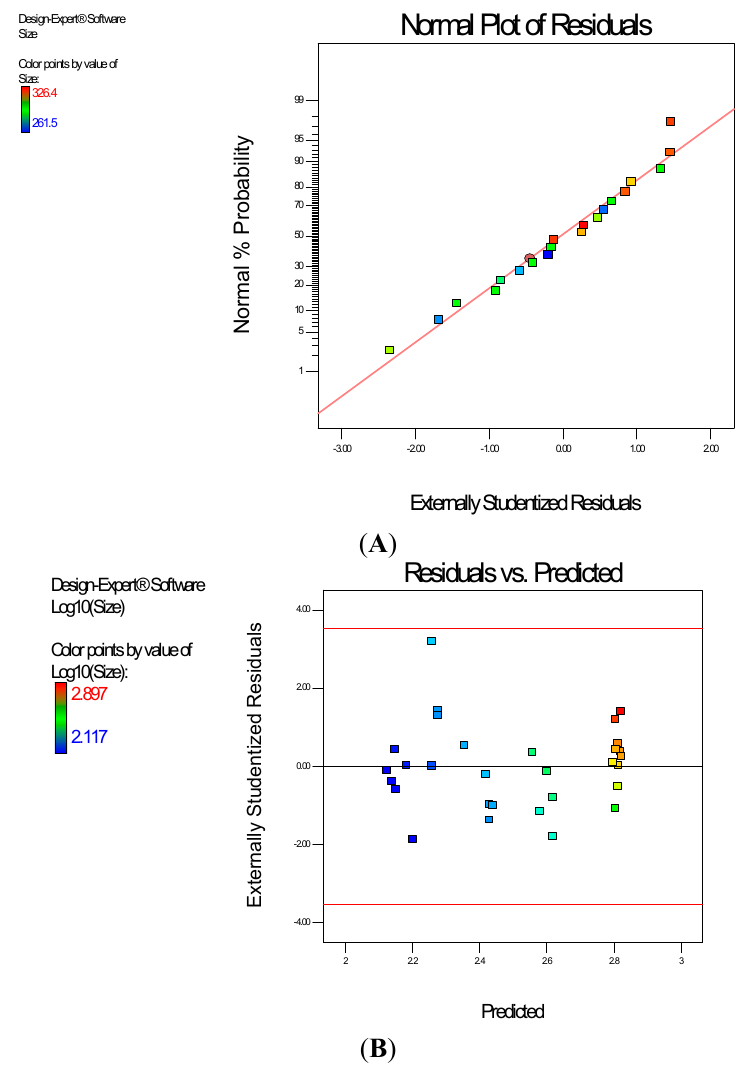
Figure 6. Diagnostic plots the particle size data of poly- ε -aprolactone-based nanoparticles: ( A ) Normal Plot of Residuals ( B ) Residuals vs. Predicted.